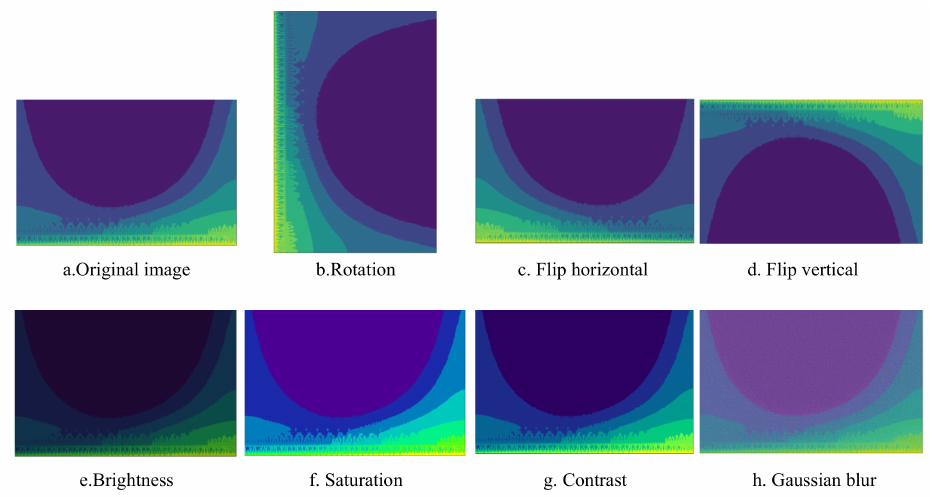
Figure 3. Example of machine tool OS images after data